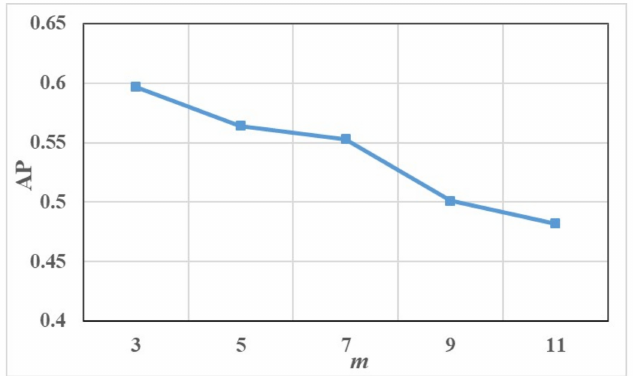
Figure 15. Results of ISASDNet with different length m of two 1D convolution kernels. The recogni- tion accuracy of ISASDNet decreases with the increase in m